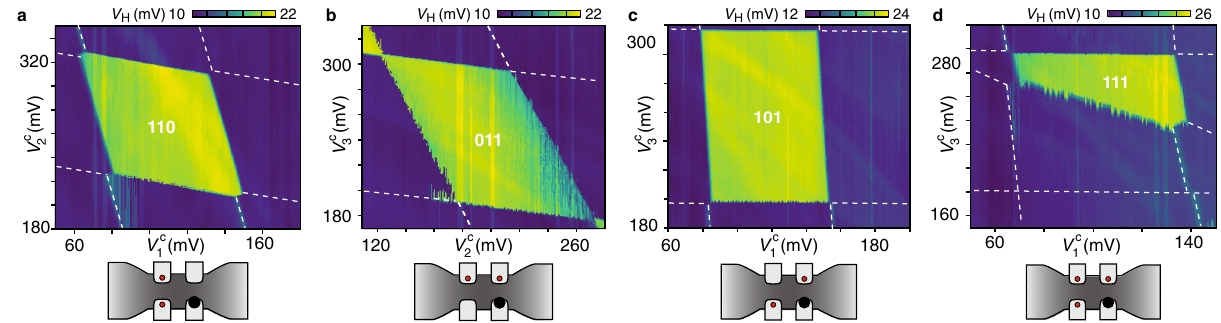
. 1 ; 2 ; 3 fi xed at a larger positive voltage, 2